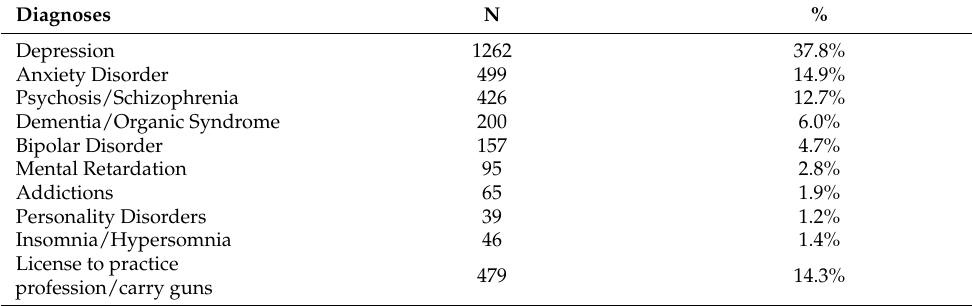
Table 2. The most common diagnoses in patients evaluated by MMHU ( n = 3343).